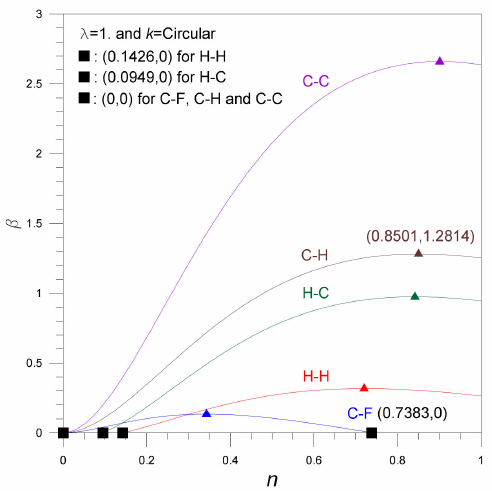
Figure 3. Curves of β versus n .